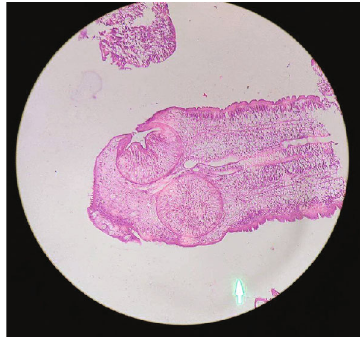
Figure 4: Microbiological assessment of the parasite. Note the refractile cuticle with reticular tissue. The subcuticular layer consisted of aggregated subcuticular cells, small myo fi ber bundles with scolex, two suckers, and birefringent four